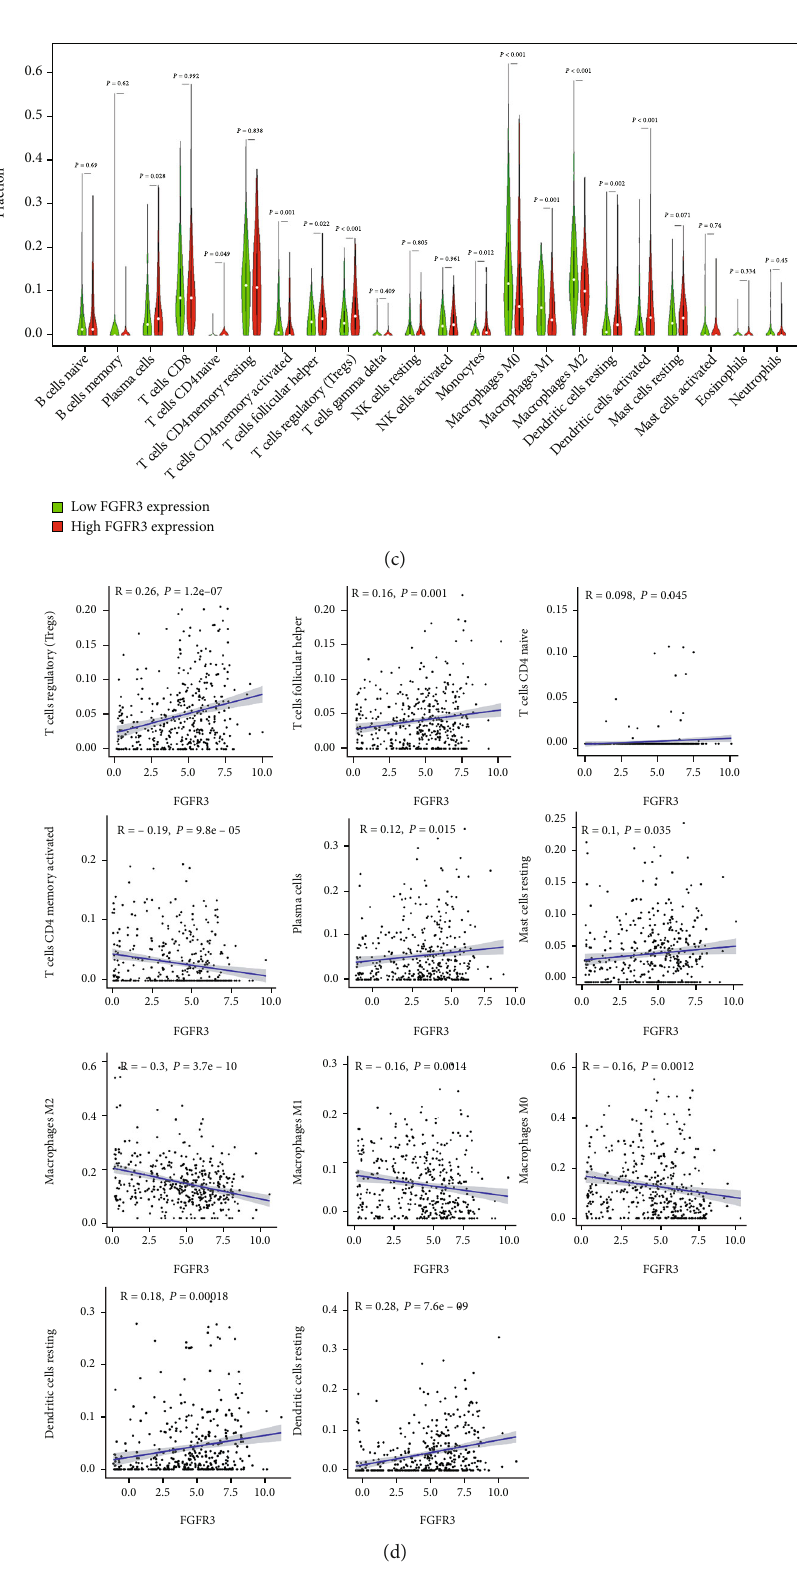
Figure 7: Relationship between FGFR3 and immune cell in fi ltration. (a) The proportion of in fi ltrated immune cells in bladder cancer patients; (b) heatmap of the correlation between immune cells; (c) changes in the median ratio of 22 in fi ltrated immune cells in bladder cancer samples from the high FGFR3 expression group and low FGFR3 expression group; (d) the association between the variation trend of the proportion of 11 kinds of immune cells and FGFR3